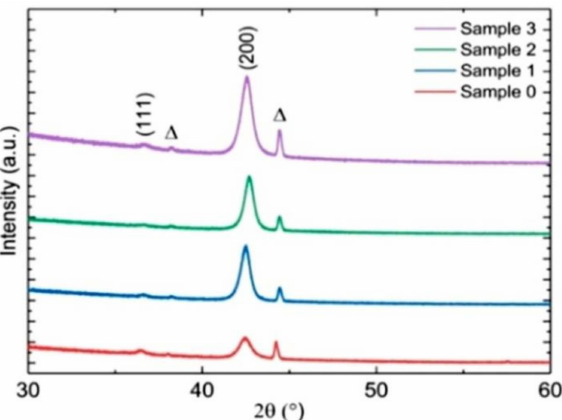
Figure 6. XRD patterns of Samples 0–3 in the range 30–60 ◦ , where ∆ represents the background peak [42].